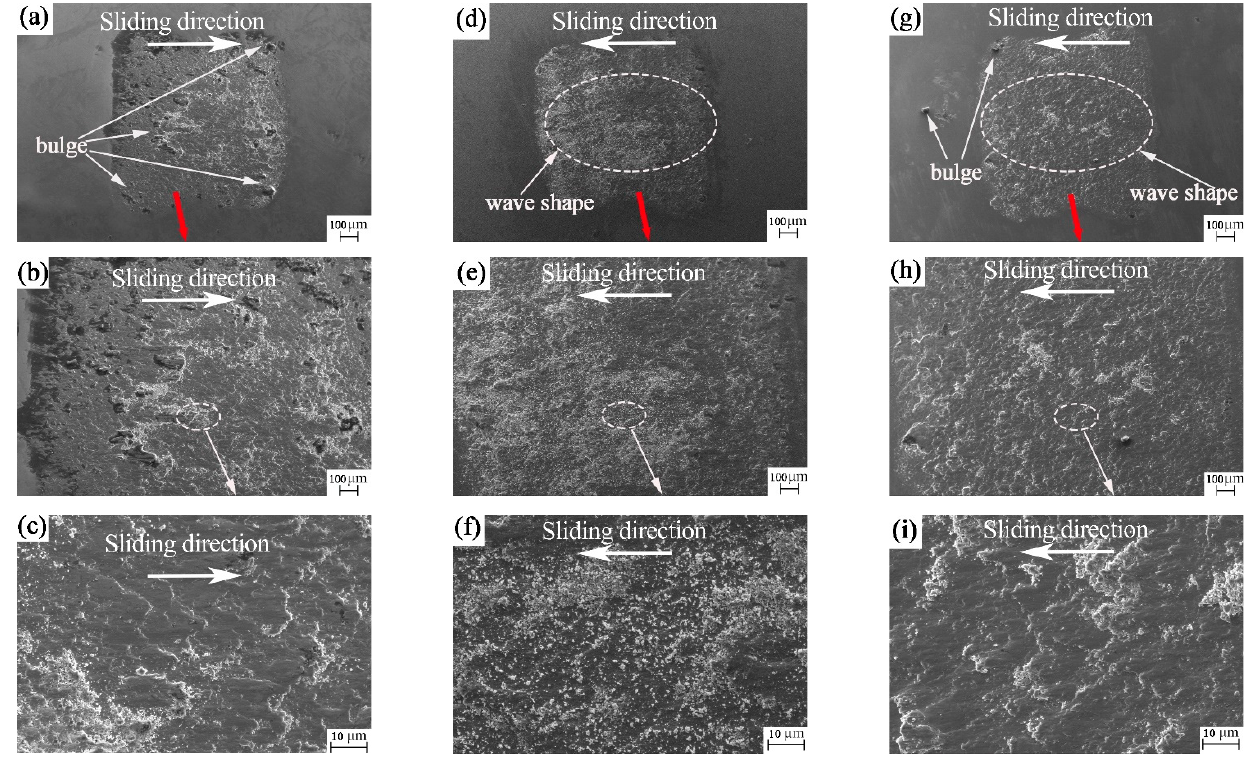
Figure 9. SEM images of the picosecond textured worn balls: ( a – c ) rotation radius 15 mm; ( d – f ) rotation radius 18 mm and ( g – i ) rotation radius 22.5 mm.